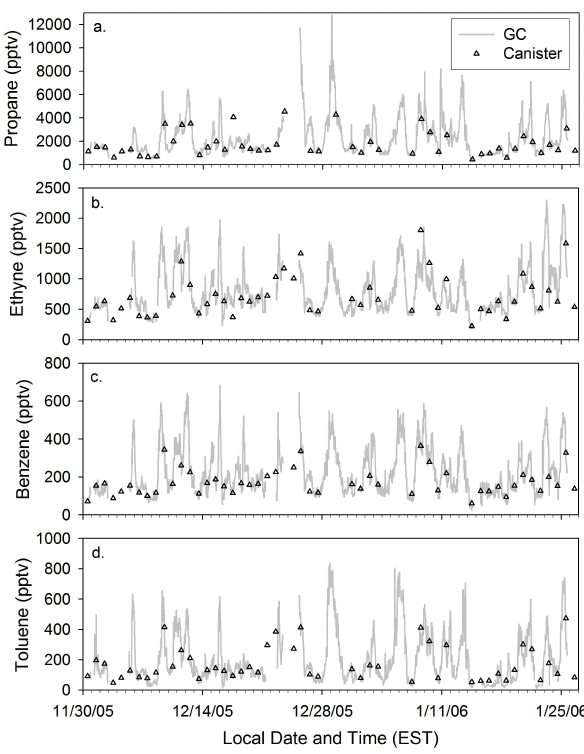
Fig. 11. Comparison between (a) propane, (b) ethyne, (c) benzene, and (d) toluene data from the automated TF GC system during De- cember 2005–January 2006 and the daily canister samples collected during the same time period. Note: the canister samples with mix- ing ratios > 95th percentile for each month have been